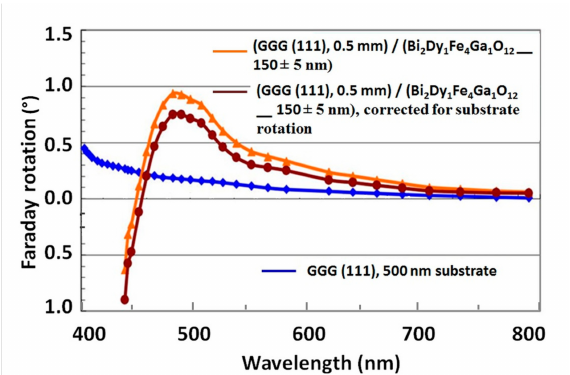
Figure 1. Spectral dependencies of Faraday rotation measured for nanocrystalline films of composition Bi 2 Dy 1 Fe 4 Ga 1 O 12 at the saturated magnetization state.